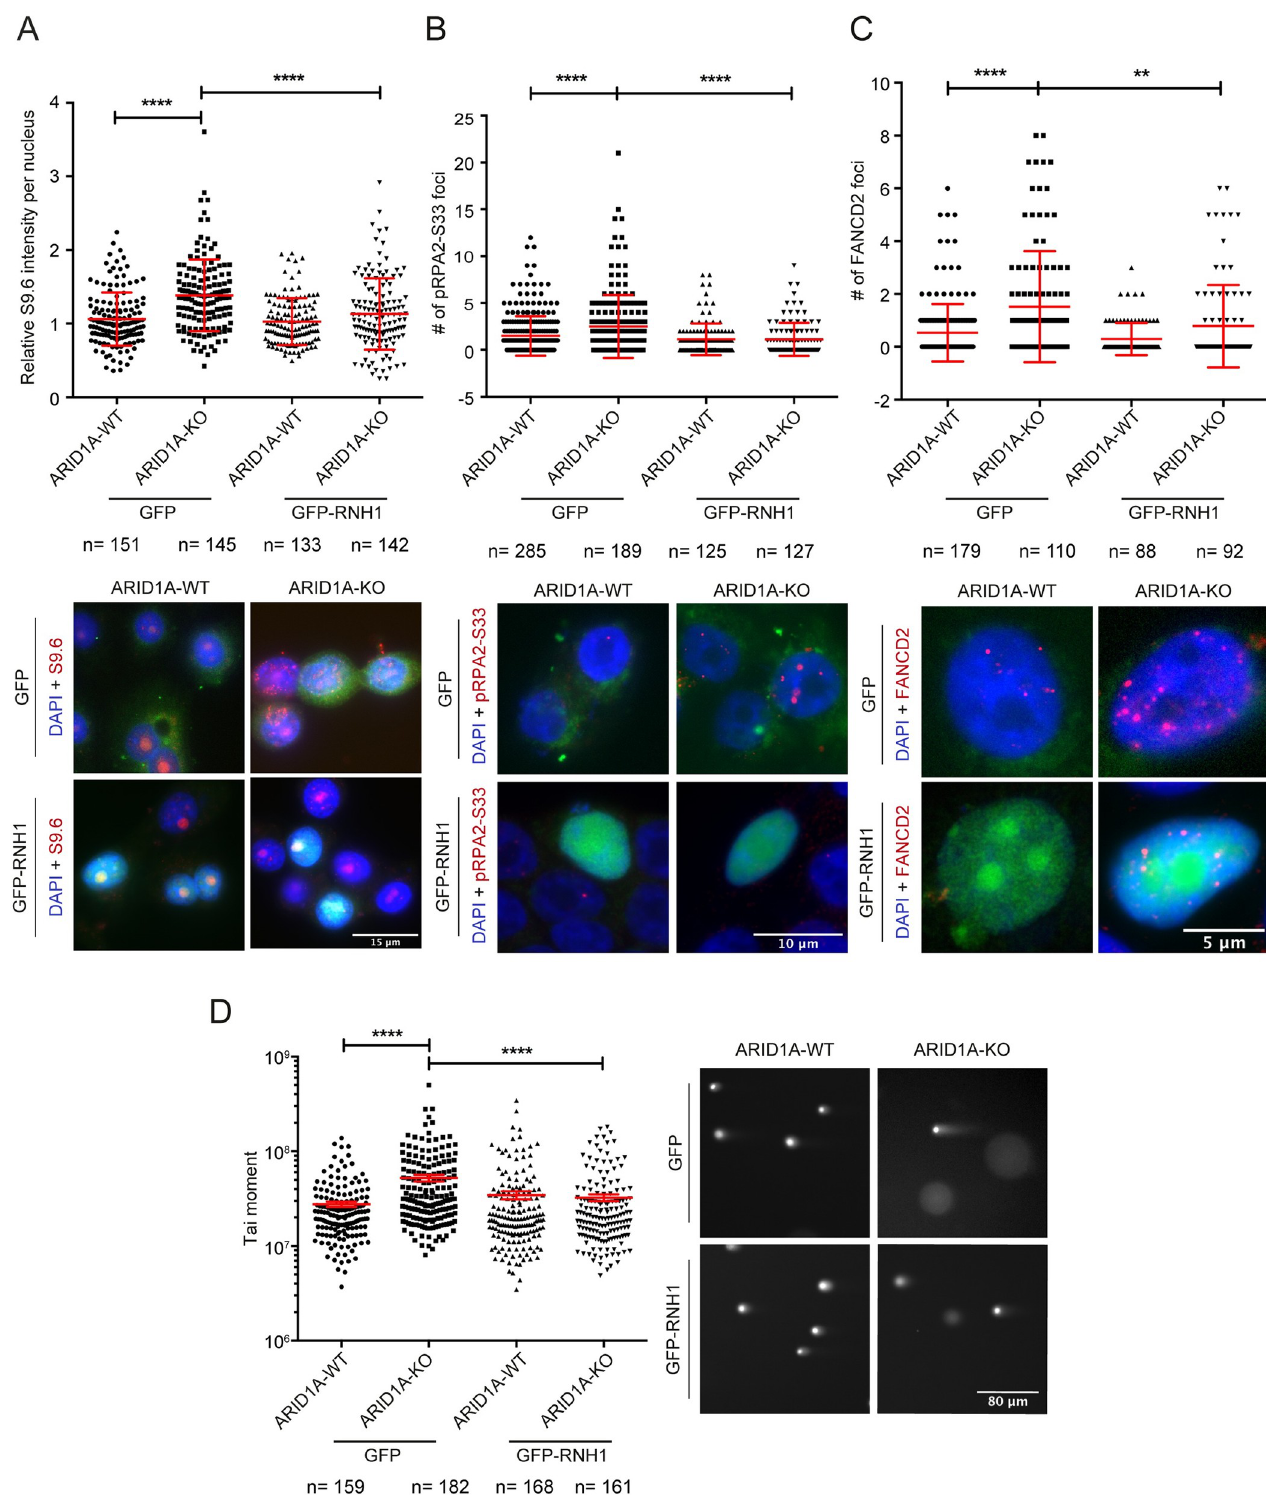
Fig 2. RNaseH-dependent R-loop accumulation and replication stress phenotypes in ARID1A-KO. (A-C) Quantification (top) and representative images (bottom) of S9.6 staining intensity per nucleus (A, left), RPA2-S33P foci (B, middle) or FANCD2 foci (C, right) in WT and ARID1A-KO RMG1 cells. Cells were transfected with either a control vector (GFP) or one expressing GFP-RNaseH1 (GFP-RNH1). For A, N = 4; ���� p < 0.0001 by ANOVA; mean ± SD. For